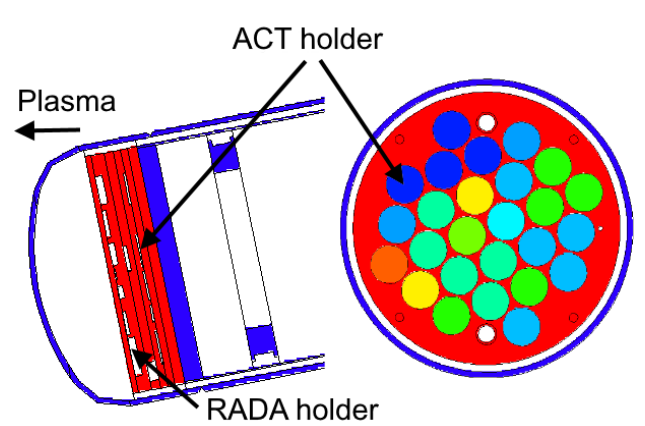
Fig. 4 MCNP model of the LTIS with marked ACT and RADA holder and direction of plasma. The ACT holder is filled with different ITER samples and dosimetry foils.